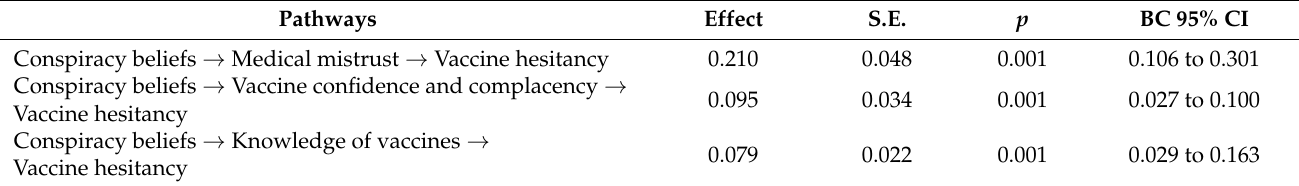
Table 4. Standardized direct effect, indirect and total effect of the variables on vaccine hesitancy ( N = 1015).